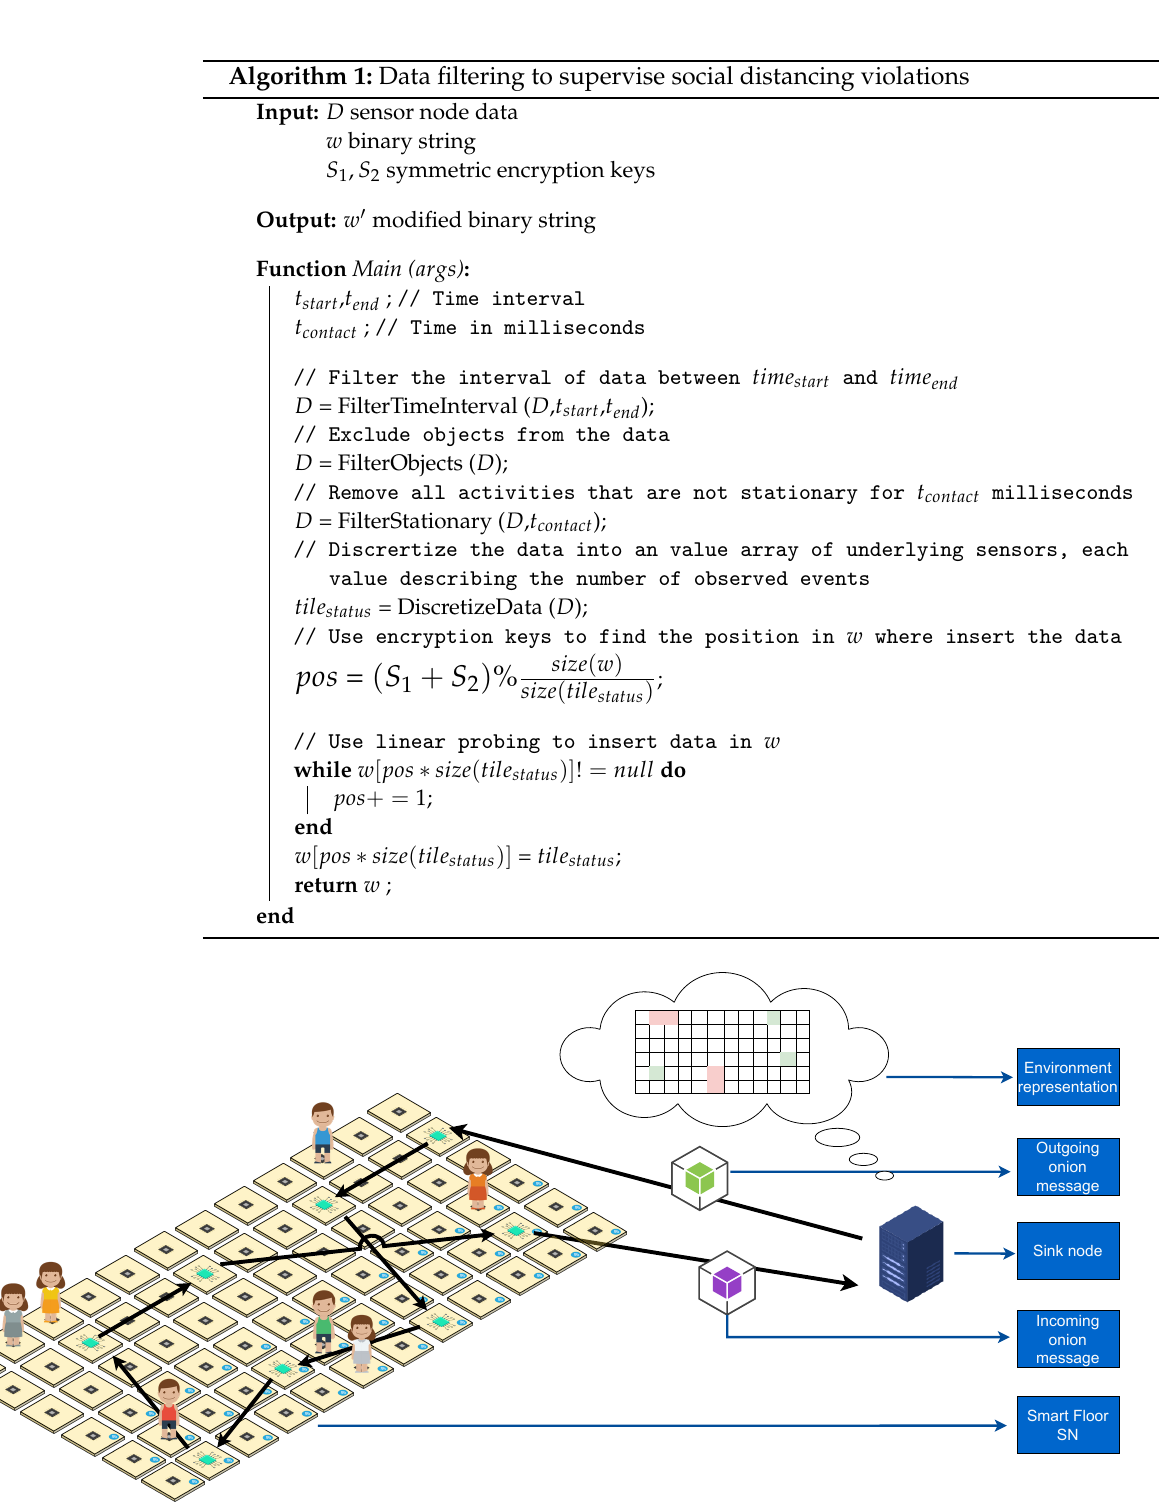
Figure 7. The figure displays the data acquisition layer relying on the privacy-preserving communi- cation protocol in [13]. The environment representation highlights where the social distancing was violated (red-colored